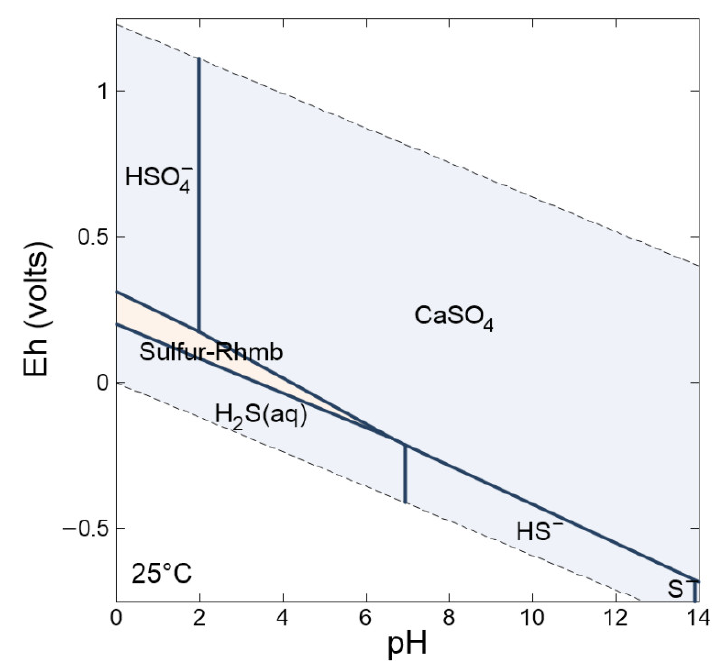
Figure A32. High sulfur 1500 mg/L, Ca 5 mM (200 mg/L), bicarbonate 7 mM (427 mg/L), sulfate 4 mM (384 mg/L), and chloride 2 mM (71 mg/L).